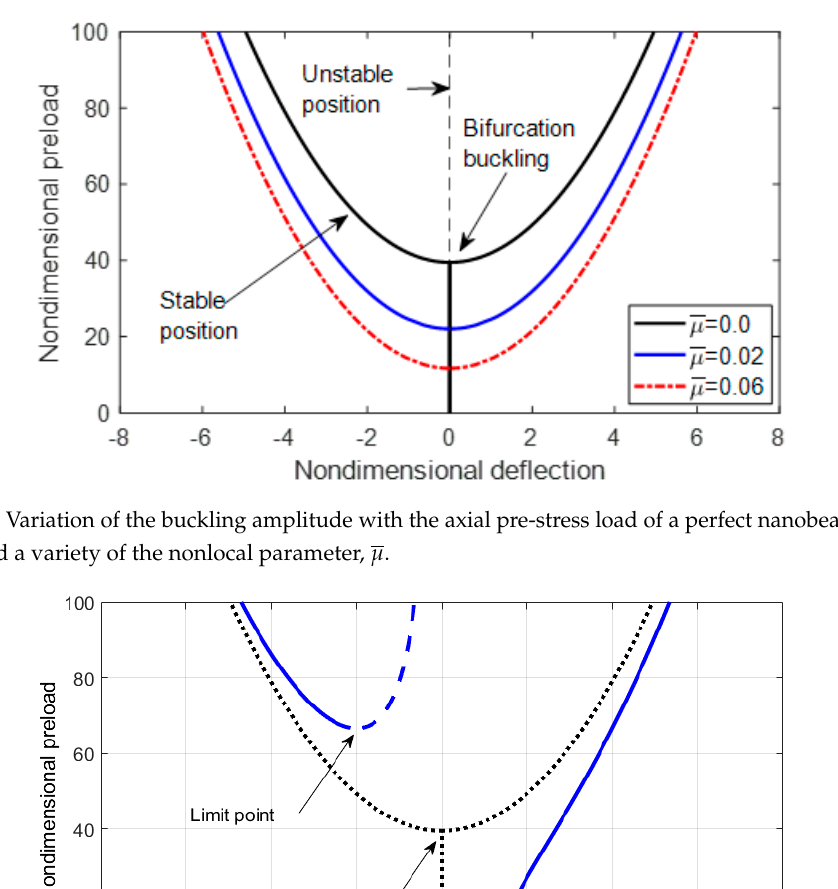
Figure 3. Variation of the buckling amplitude with the axial pre-stress load of a perfect nanobeam with 𝛼 = 1 and a variety of the nonlocal parameter, 𝜇̅.